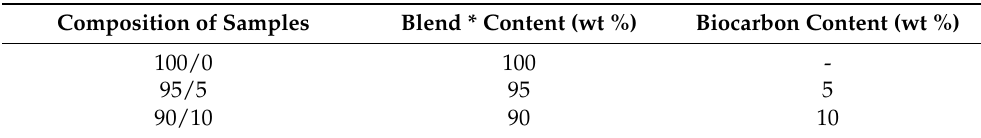
Table 2. Nomenclature and composition of